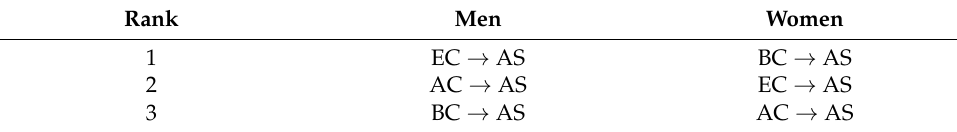
Table 6. Gender differences of environmental concerns.